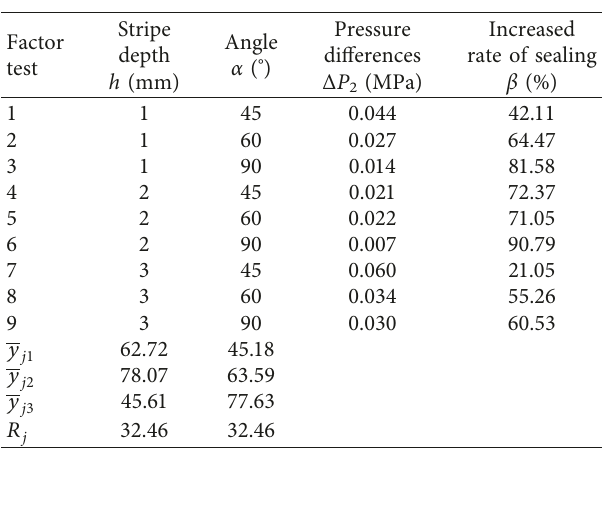
Table 1: Factors and levels. Table 2: Experimental scheme and results.